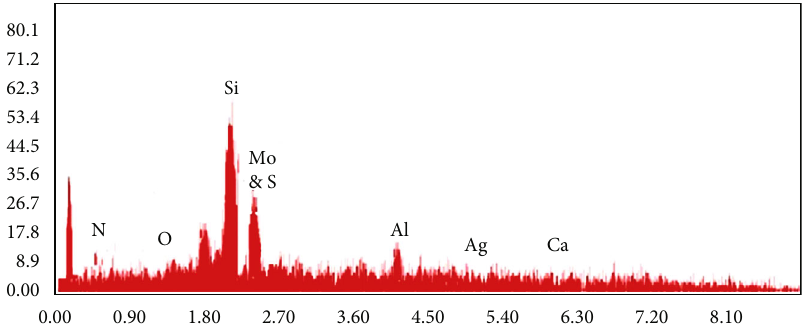
Figure 11: EDX analysis of A-IV-coated solar